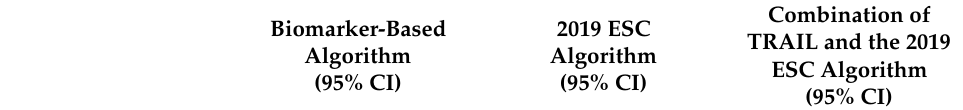
Figure 3. Risk assessment using the biomarker-based strategy based on hs-cTnI and TRAIL. The number (%) of patients with an adverse 30-day outcome is shown for each strategy. Hs-cTnI levels >0.04 ng/mL are defined as positive. PE: pulmonary embolism; hs-cTnI, high-sensitivity cardiac troponin I; TRAIL, tumor necrosis factor-related apoptosis-inducing ligand. Table 3. Prognostic performance of risk assessment strategies for the prediction of an adverse 30-day